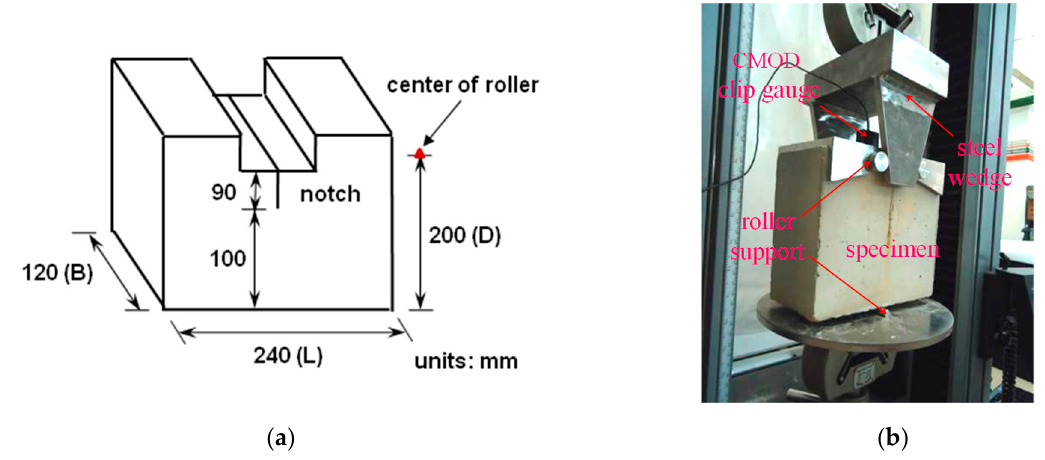
Figure 7. (a) Specimen and (b) test apparatus for wedge split test. Figure 7. ( a ) Specimen and ( b ) test apparatus for wedge split test.